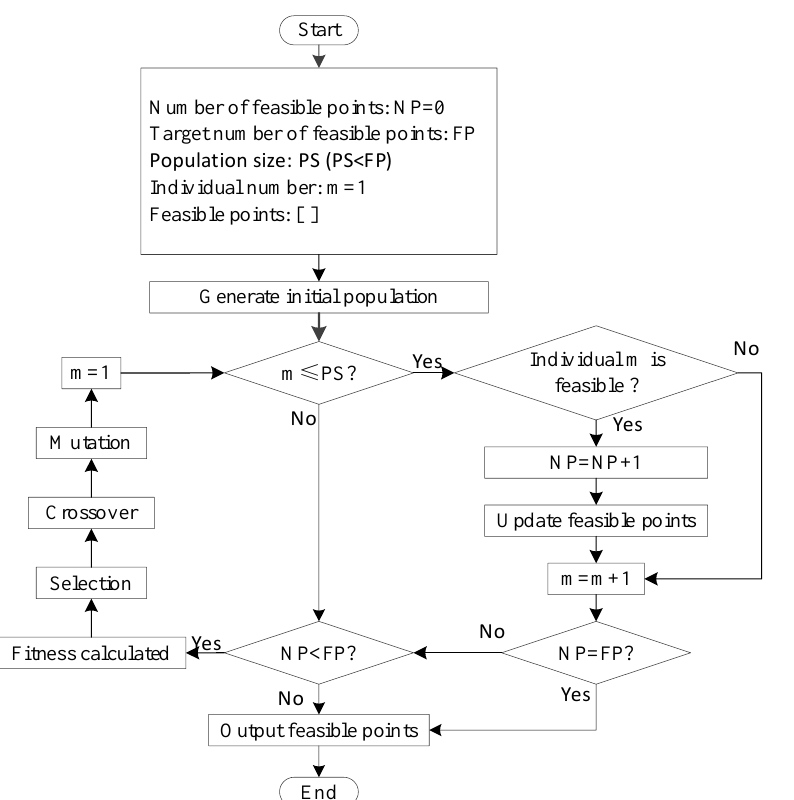
Figure 6. The flowchart for the generation of feasible points.